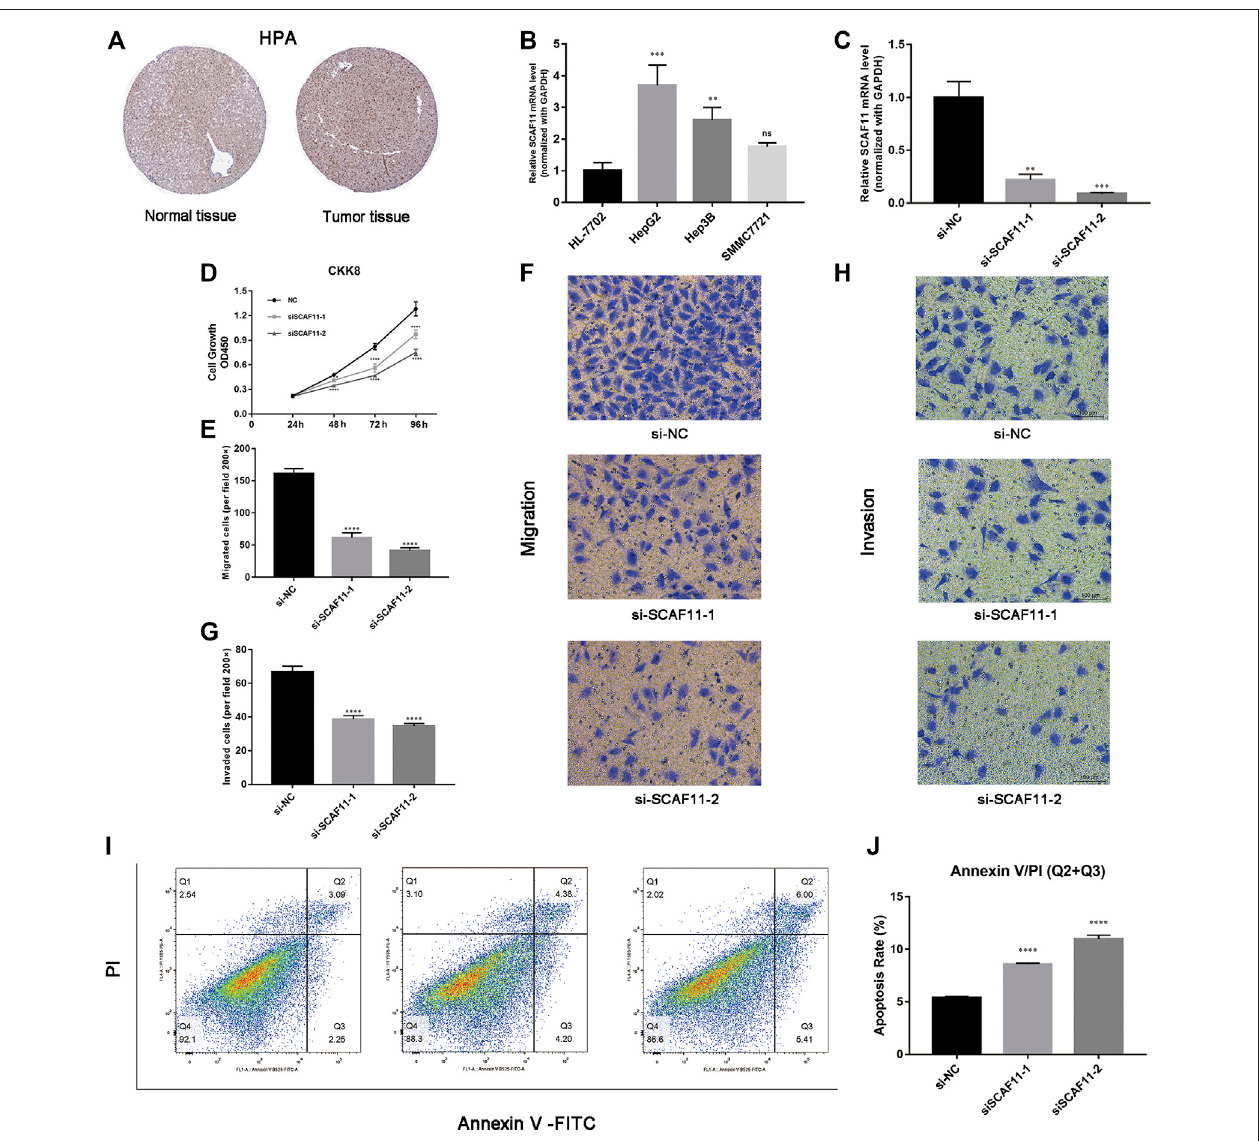
FIGURE 8 | SCAF11 promoted proliferation, migration, and invasion and suppressed apoptosis of HCC cell lines. (A,B) The HPA and qRT – PCR results showed thatSCAF11wasupregulatedinHCCcelllines. (C) SCAF11wasinhibitedbysiRNAs. (D) Cellproliferationassay. (E – H) AnalysisoftheeffectofSCAF11onthemigration and invasion of HCC cells. (I,J) Analysis of the effect of SCAF11 on HCC cell apoptosis by fl ow cytometry. ** p < 0.01; *** p < 0.001; **** p <